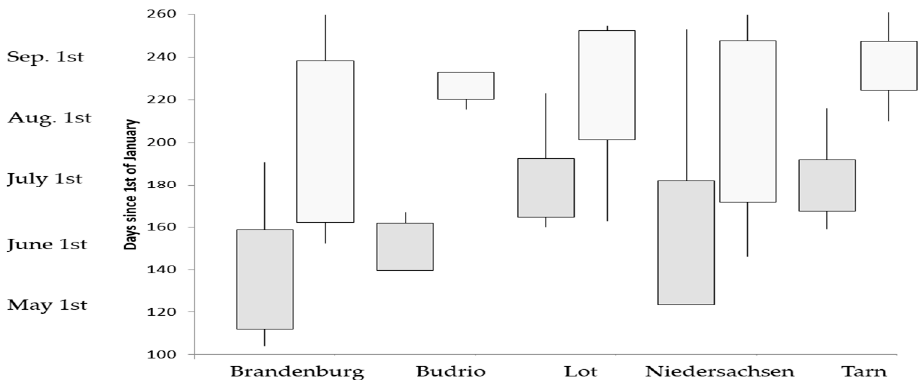
Figure 3. Start (gray color) and end (white color) of irrigation season per region. The box shows the mean date plus or minus one standard deviation. The line indicates the extremes, i.e., the minimum and maximum date of beginning and end of the irrigation season.